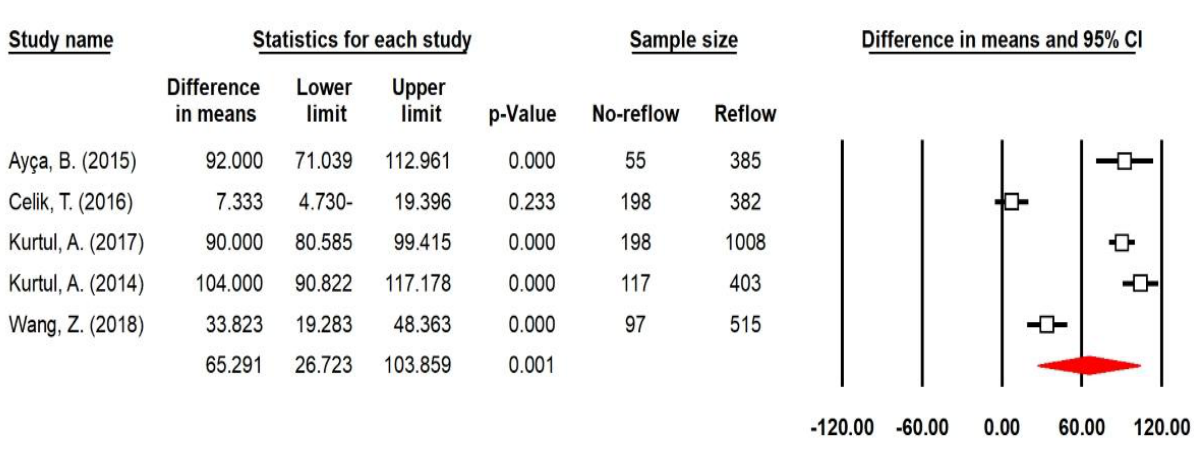
Figure 2. Forest plot of difference of PLR means between no-reflow and